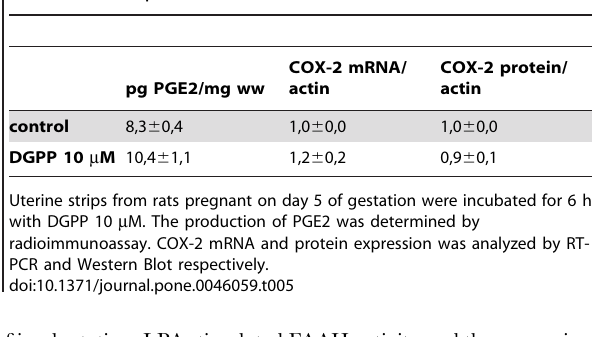
Table 5. Effect of DGPP 10 m M on the production of PGE2 and on the expression of